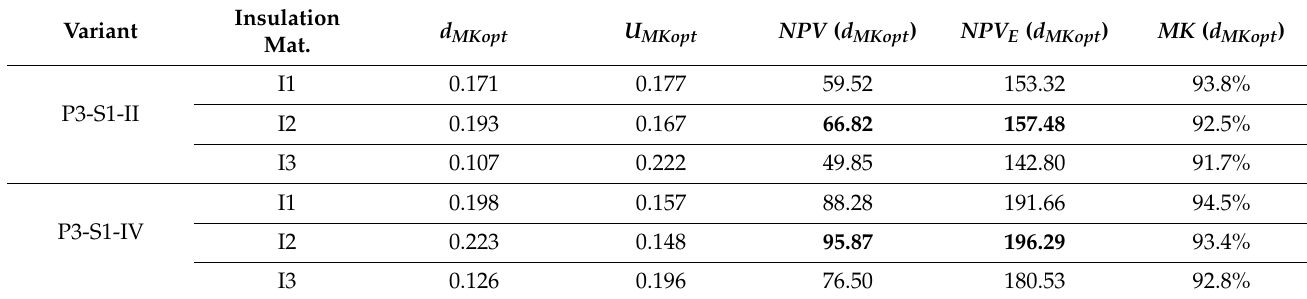
Table 13. Summary of results for Variant P3-S1-II I P3-S1-IV.